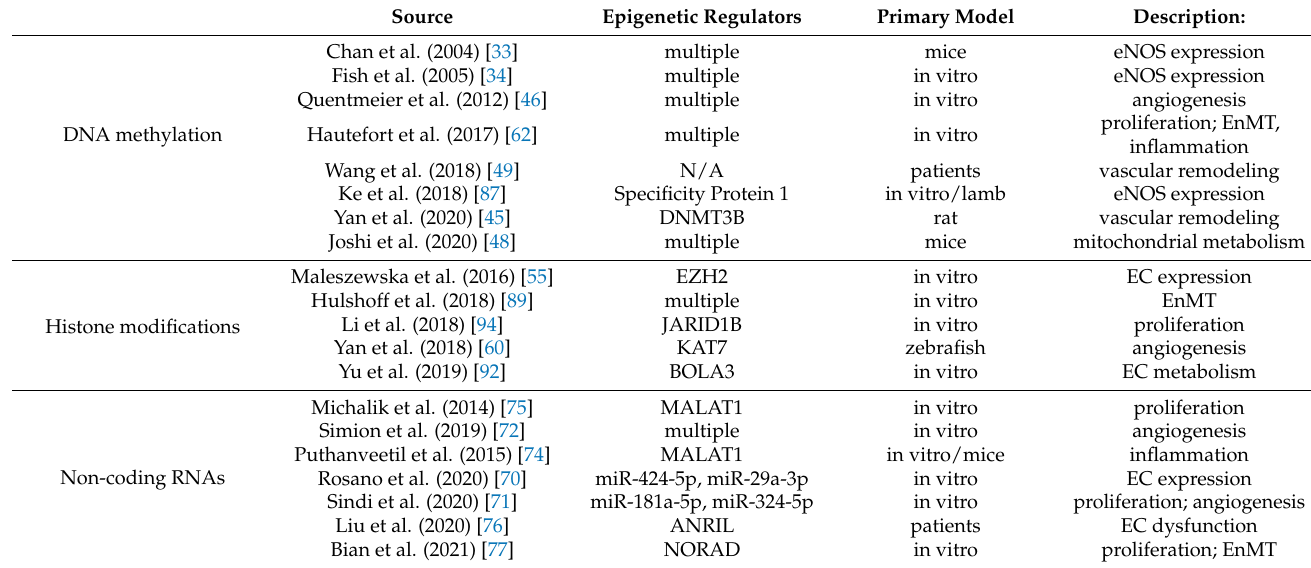
Table 1. Previous literature of putative epigenetic pathways and regulatory factors associated with PAH and endothelial